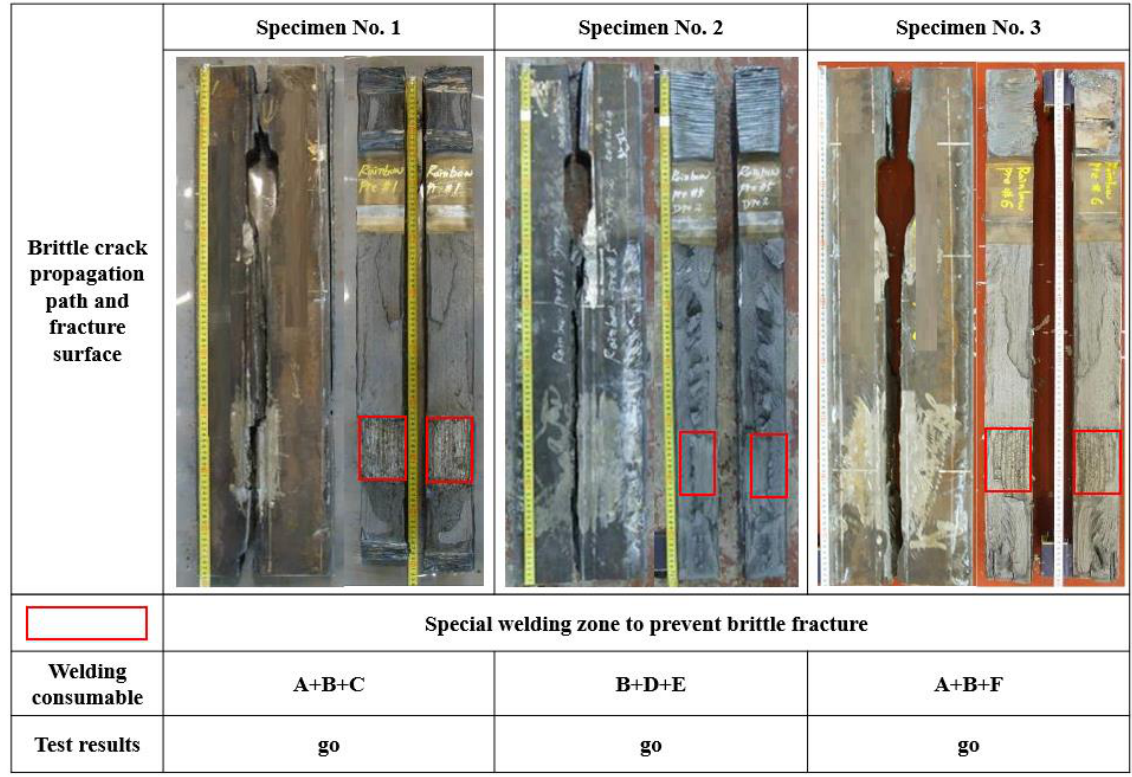
Figure 6. Brittle crack arrest test results of specimens 1, 2, and